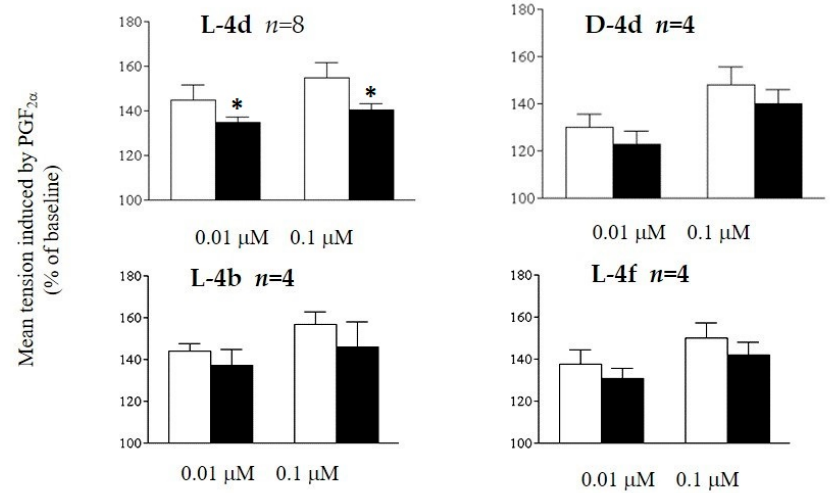
Figure 2. Mean tension induced by PGF α on murine myometrial tissue alone (white bar) and in the presence of peptide at two different concentrations. * p < 0.05 compared with vehicle ‐ treated.